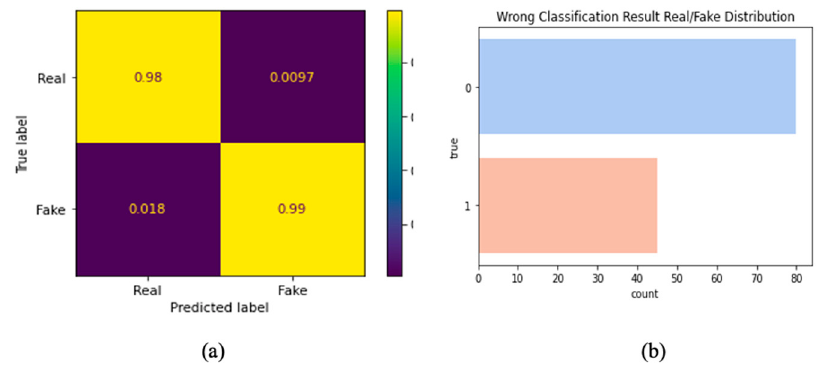
Figure 6. ( a ) Confusion matrix ( b ) Wrong classification result (fake/real).